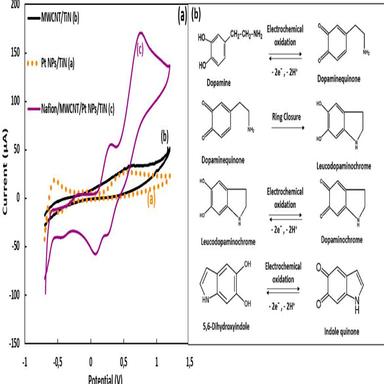
(a) CVs of Pt NPs/TiN electrode (curve a), MWCNT/TiN electrode (curve b), MWCNTs/Pt NPs/TiN electrode, and Nafion/MWCNTs/Pt NPs/TiN electrode in PBS solution (50 mM, pH = 7.4) containing 100 µM DA at scan rate of 50 mV/s. (b) supposable scheme of DA electrooxidation mechanism at Nafion/MWCNTs/Pt NPs/TiN electrodes surface.